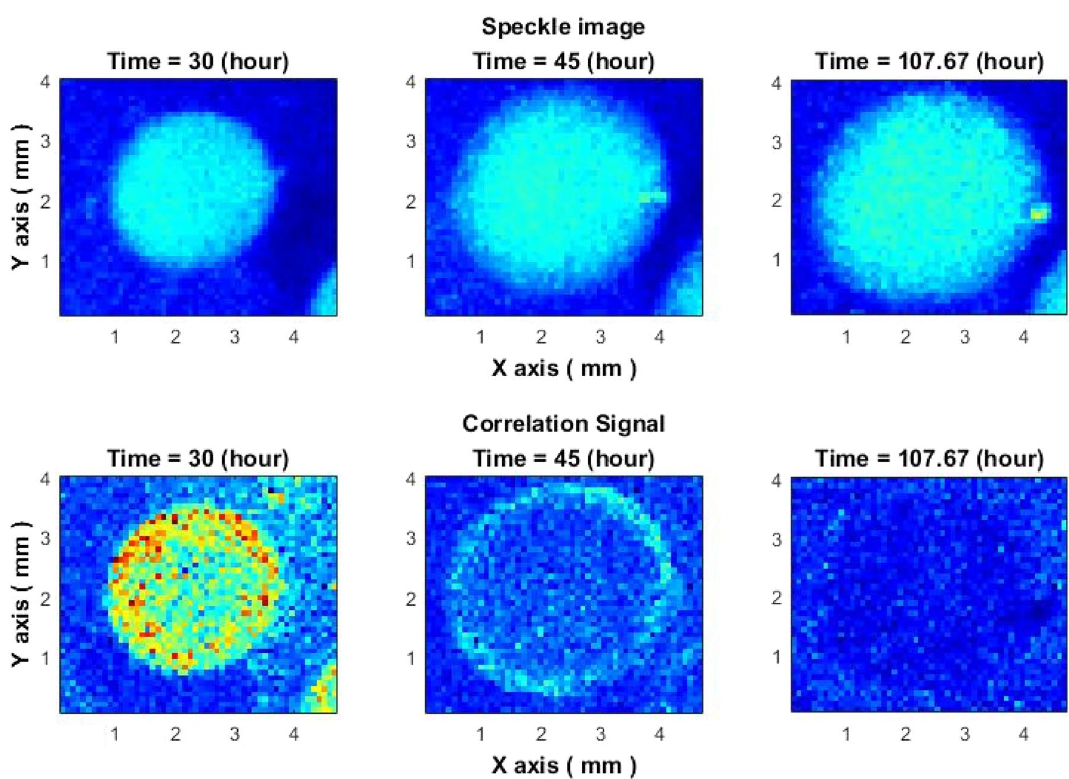
Figure 12. Activity ring signal ceases over time in aging colonies of Vibrio natriegens . Top: colony speckle images, Bottom: image after applying subpixel correlation algorithm, cease of activity